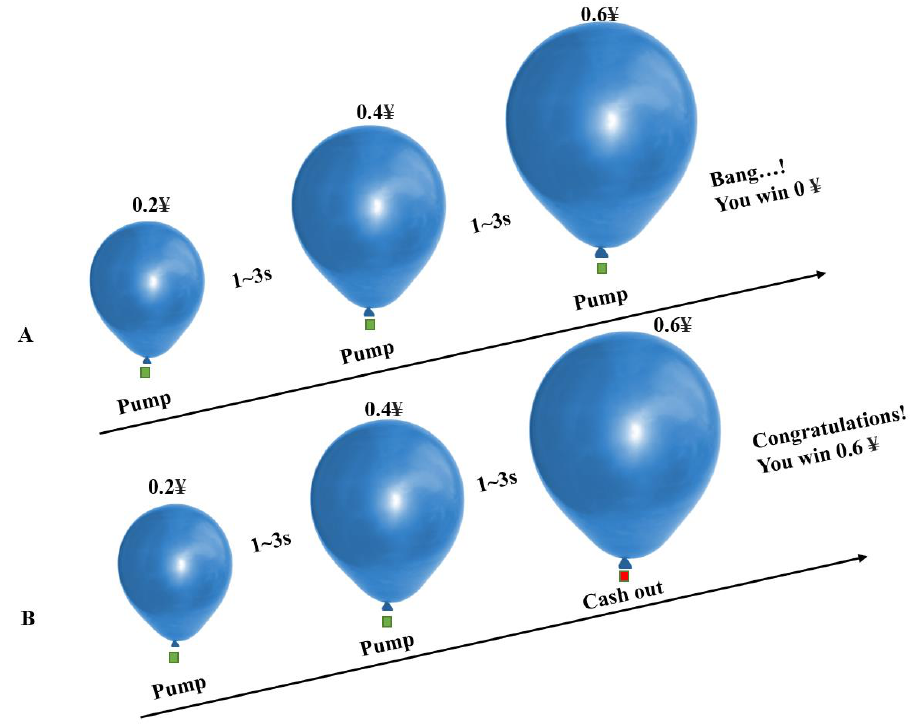
Figure 2. Balloon analog risk task. A exploded balloon trials. B unexploded balloon trials. A virtual uninflated blue balloon is shown in the center of the screen. Participants can press the green button to inflate balloon or red button to discontinue inflation. Participants can receive CNY 0.2 reward for each press of the green button if the balloon continues to inflate, or lose all of their reward if the balloon explodes. Each time the participants completed a selection, the game would have a rest period of 1 to 3 s; there was a rest period of 2 to 6 s between trials, and a total of 40 trials.